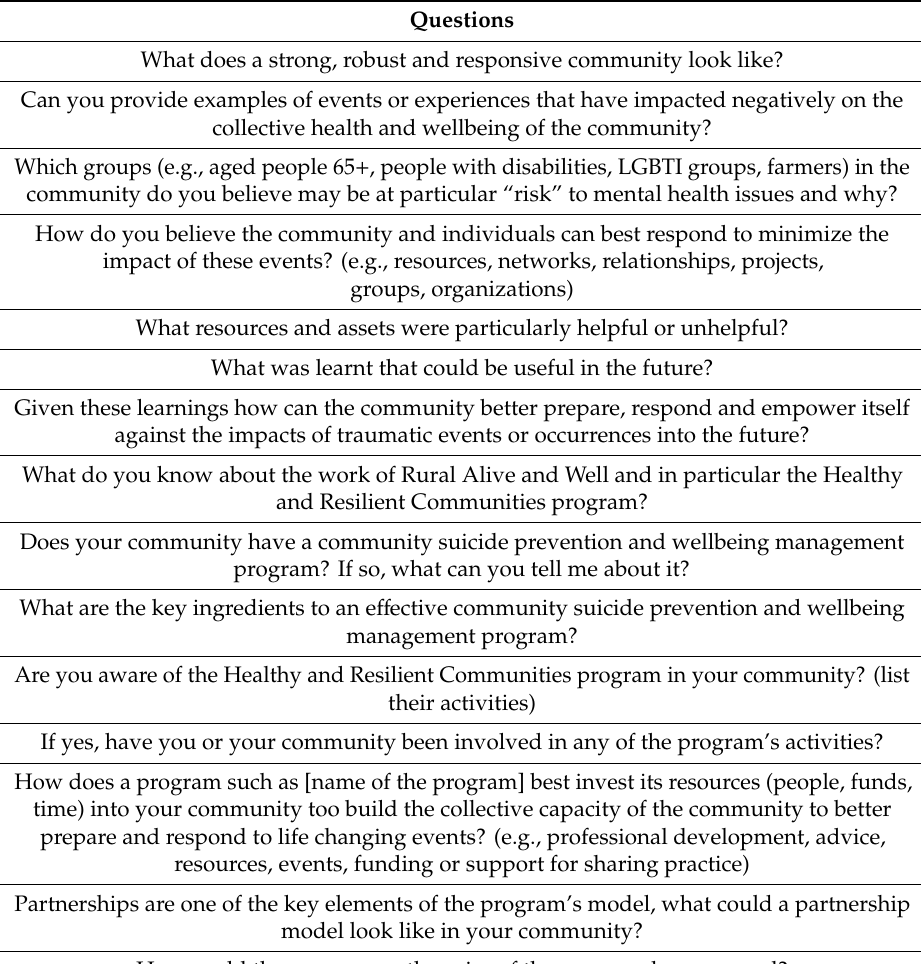
Table 1. Interview and focus group interview